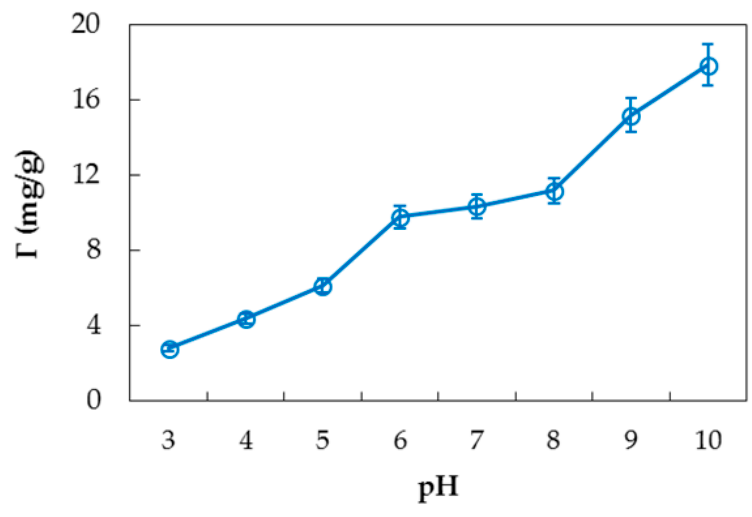
Figure 6. Effect of pH on PDADMAC adsorption on nanosilica. ( C i (PDADMAC) = 1.0 g/L, adsorbent dosage 10 mg/mL, 100 mM KCl). Error bars show standard deviations of three replicates.